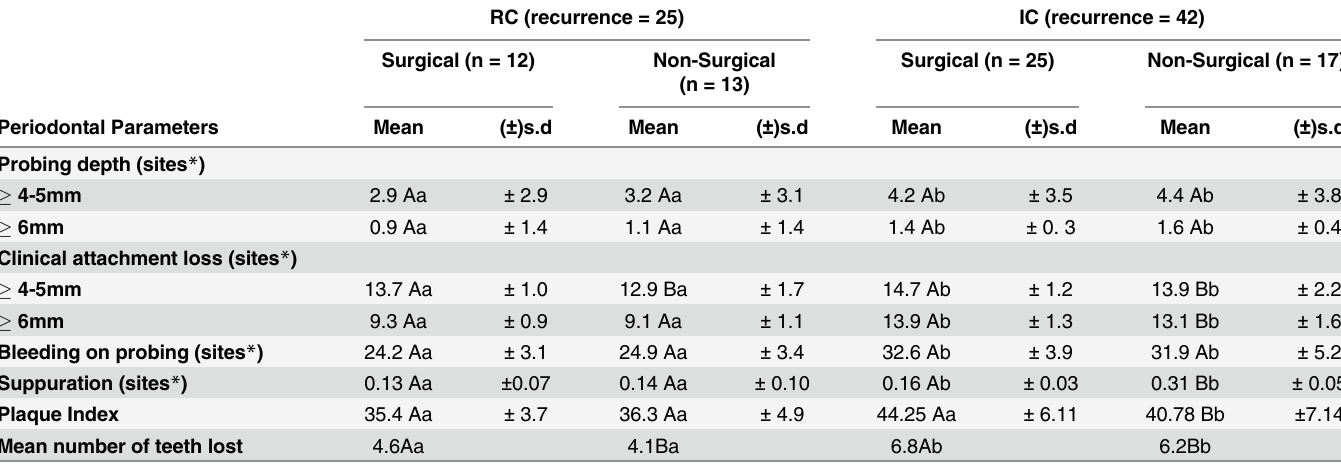
Table 3. Periodontal status of individuals with recurrence of periodontitis with surgical or non-surgical procedures during PMT at final examination. RC (recurrence = 25)